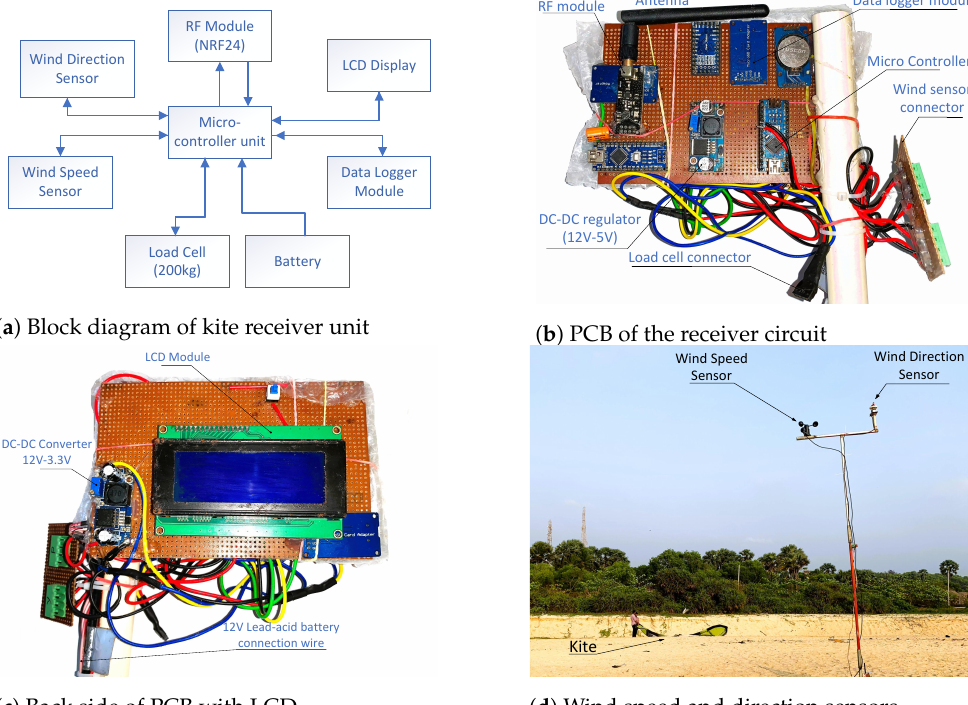
Figure 8. Sensor system on the ground: ( a ) Block diagram of the kite data receiver system on the ground, ( b ) Implementation of the sensor data receiver circuit in the PCB, ( c ) Back side of the PCB with LCD, ( d ) Wind speed and direction sensors at the testing